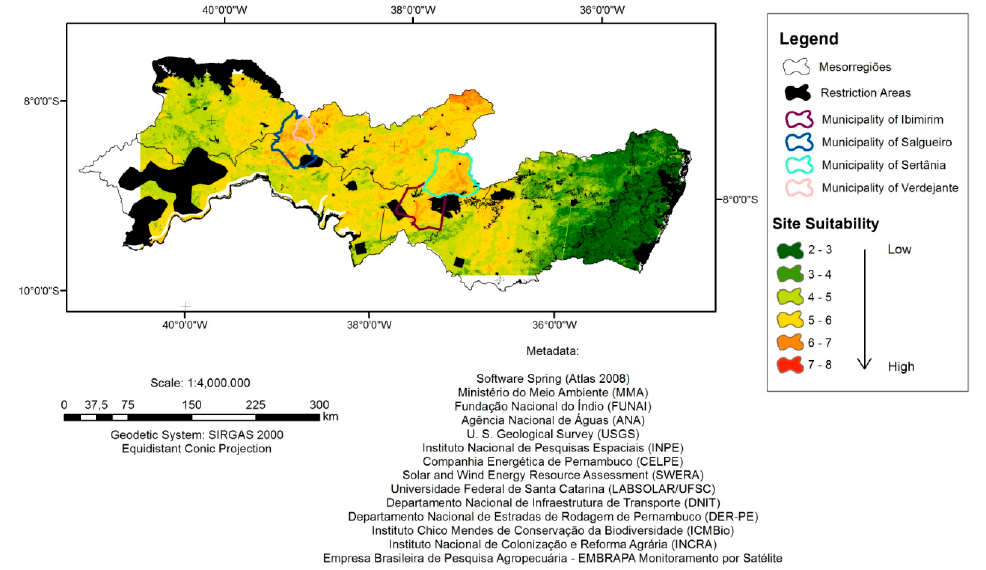
Figure 12. Site Suitability Map for the Installation—Scenario 1.